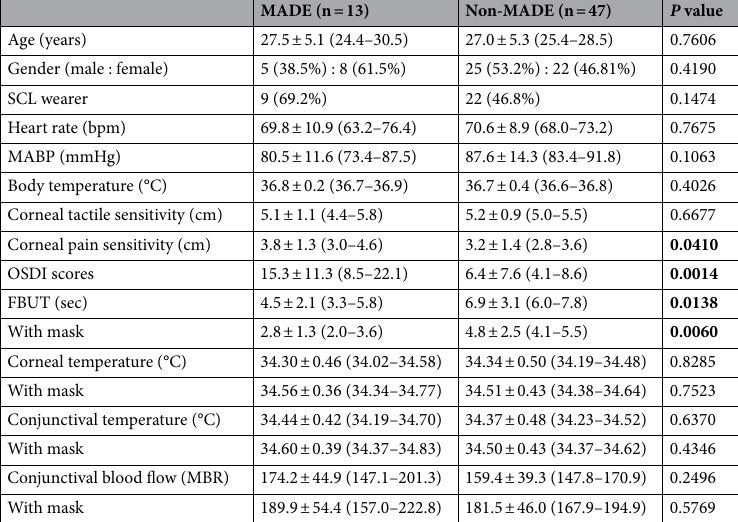
Table 2. Comparison of the results between the MADE and non-MADE groups. The data are expressed as the average ± deviation (95% confidence interval). Parameters in the MADE and non-MADE groups. The data are presented as the average ± deviation (95% confidence interval). SCL , soft contact lens; MABP mean arterial blood pressure; OSDI Ocular Surface Disease Index; FBUT , fluorescein tear breakup time. Bold values indicate significant